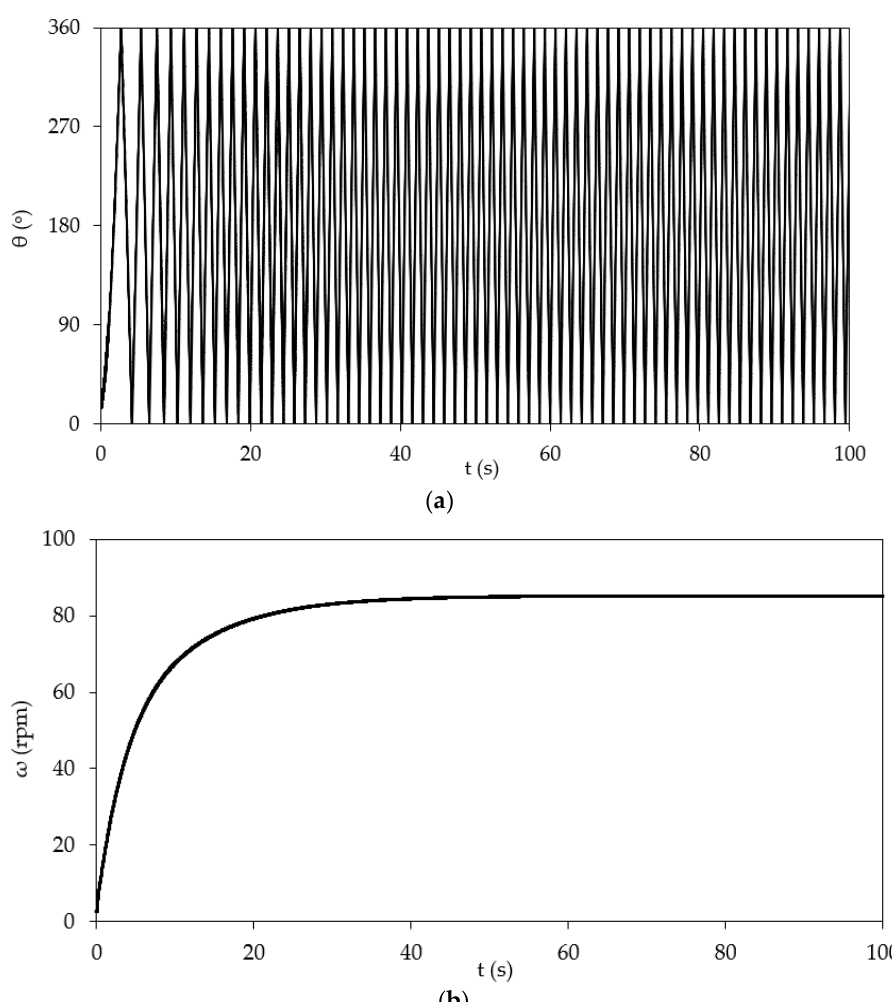
Figure 8. Rotational characteristics of the VAWT with stator.